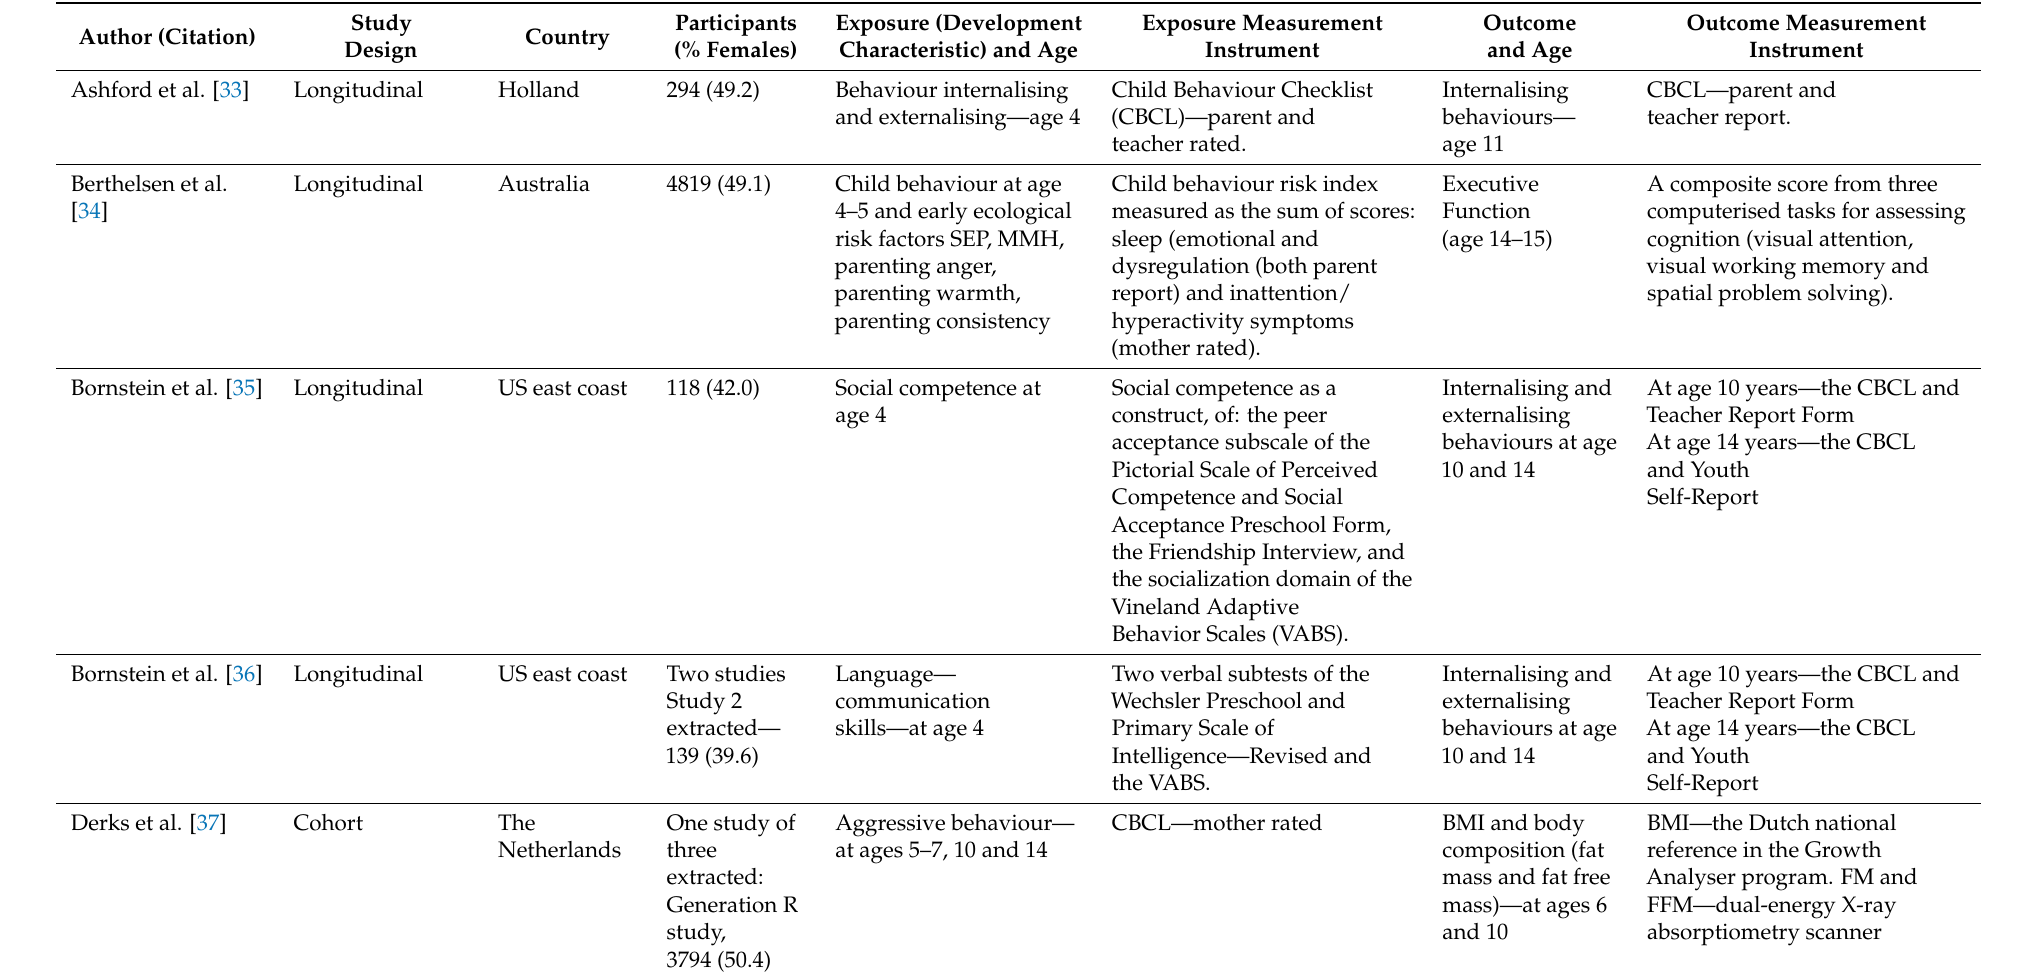
Table 3. Summary of study